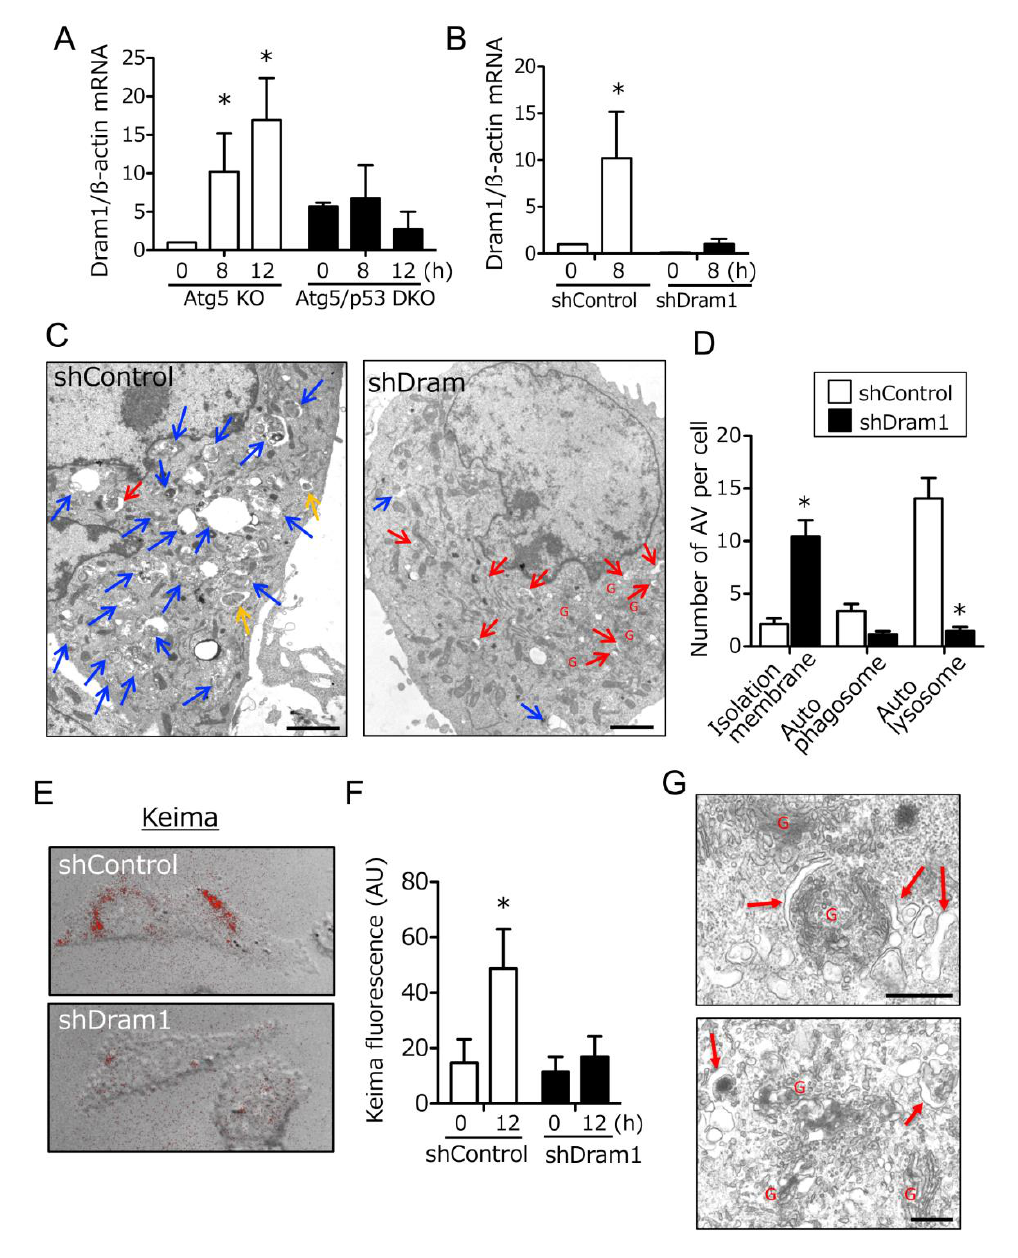
FIGURE 2: Inhibition of alternative autophagy in etoposide-treated Atg5 KO MEFs by an shRNA for Dram1. (A, B) Dram1 expression was assessed by qPCR using mRNA. (A) Atg5 KO MEFs and Atg5/p53 DKO MEFs were incubated with 10 µM etoposide for the indicated times. *p < 0.05 vs the value of “Atg5 KO 0 h”. (B) shDram1-transfected and control Atg5 KO MEFs were incubated with 10 µM etoposide for the indicated times. *p < 0.05 vs the value of “shControl 0 h”. (C, D) Electron micrograph of shDram1-transfected Atg5 KO MEFs and control Atg5 KO MEFs treated with etoposide (10 µM) for 18 h. Blue, yellow, and red arrows indicate autolysosomes, autophagosomes, and isola- tion membranes, respectively. “G” indicates Golgi membranes. In (C) , bar = 2 µm. (D) The number of each type of autophagic structure appearing in Atg5 KO MEFs treated with etoposide. shDram1-transfected and control Atg5 KO MEFs were incubated with 10 µM etopo- side for 18 h, and the number of autophagic vacuoles per cell was counted on the EM photographs. White and black columns represent the number of autophagic structures in control and shDram1-transfected Atg5 KO MEFs, respectively. Data are the mean + SD obtained from 10 cells. *p < 0.05 vs the value of “shControl”. (E, F) Keima analysis indicated the requirement of Dram1 in etoposide-induced alter- native autophagy. The indicated MEFs were treated with etoposide (10 µM) for 12 h. Alternative autophagy was then analyzed using Kei- ma. (E) Keima signals (red) were merged with images obtained from phase-contrast microscopy at 12 h. (F) The extent of Keima fluores- cence is shown as the mean + SD (n = 4). *p < 0.05 vs the value of “shControl 0 h”. (G) Electron micrograph of shDram1-transfected Atg5 KO MEFs treated with etoposide (10 µM) for 18 h. Red arrows indicate isolation membranes. “G” indicates Golgi membranes. Bar = 0.5